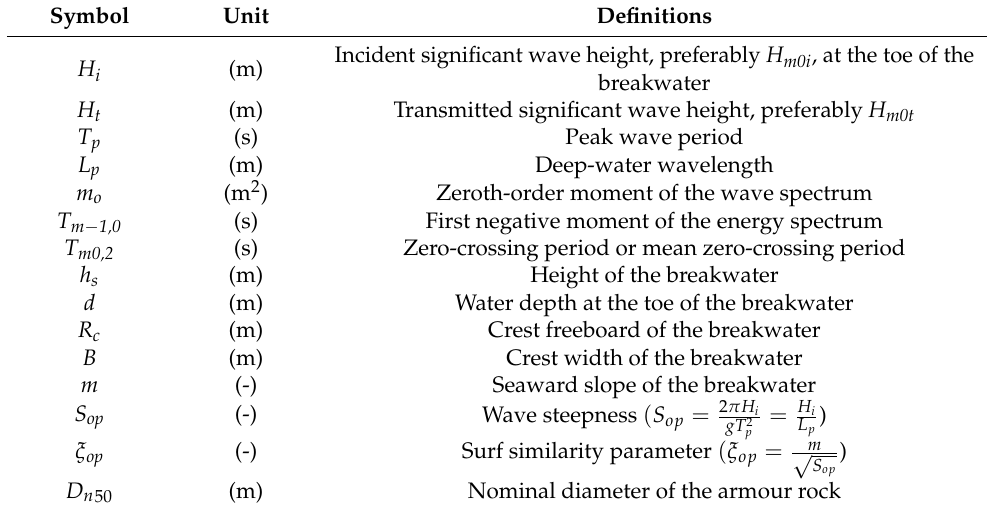
Table 1. Wave characteristics and structural parameters involved in the wave transmission phenomenon. Symbol Unit Definitions Incident significant wave height, preferably H m0i , at the toe of the H i (m) breakwater H t (m)